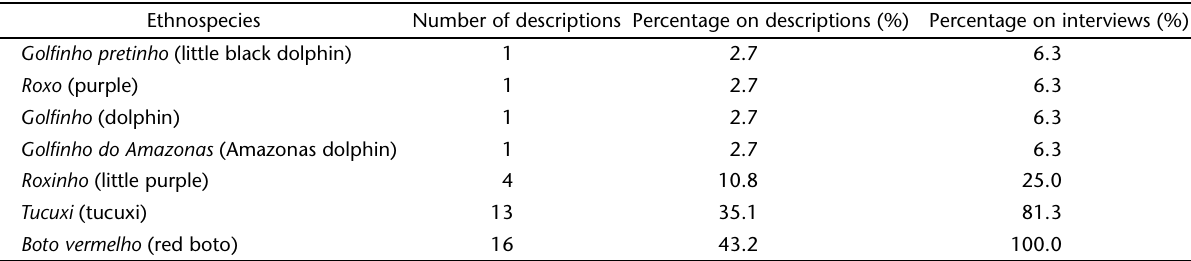
Table I. Species ethnoidentified by interviewees.